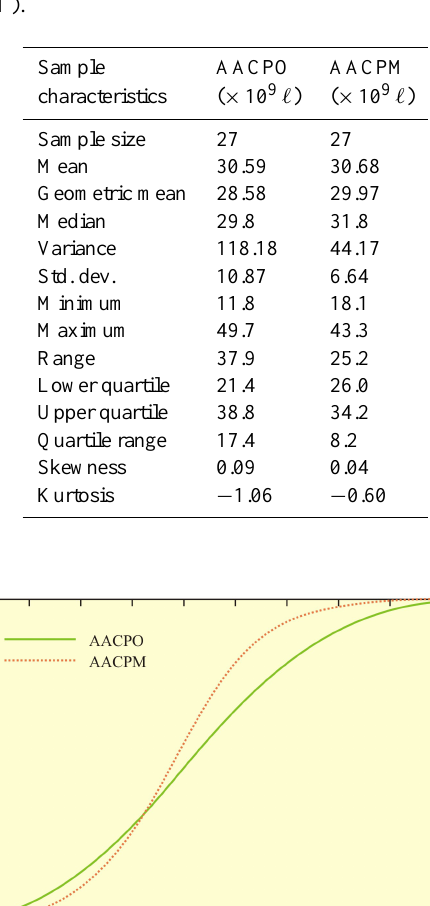
Table 3. General sample statistics for areal accumulated con- vective precipitation at the surface ( > 5mm) expressed in 10 9 ‘ after t =120min for the observed (AACPO) and model values